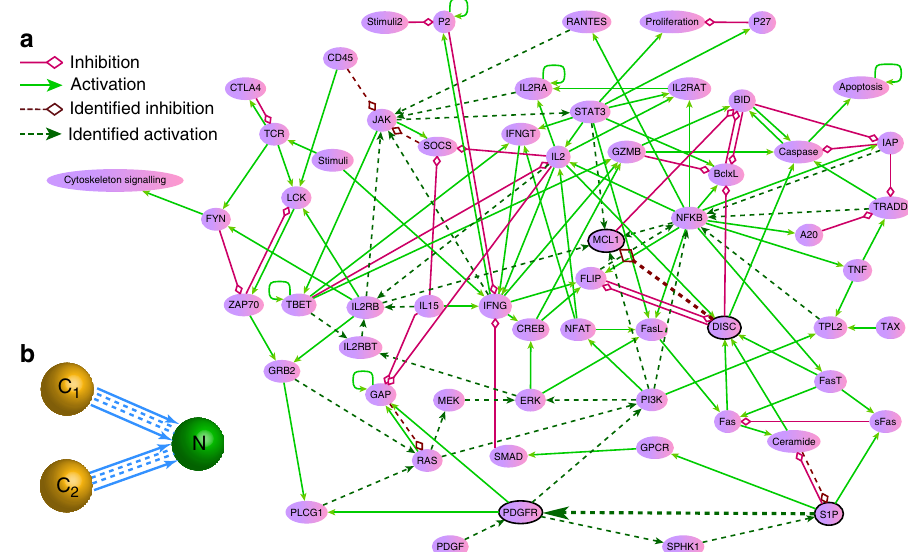
Figure 1 | T-cell survival signalling network and its attractor network. ( a ) Structure of T-cell survival network: each node is labelled with its generic name, and the arrowhead and diamond-head edges represent activation and inhibition regulations, respectively. The inhibitory edges from ‘Apoptosis’ to other nodes are not shown (for clarity). ( b ) Attractor network of the T-cell network, which contains three nodes: two cancerous states denoted as C 1 and C 2 and a normal state denoted as N . The two directed edges in the attractor network are multiple, each containing altogether 48 individual edges corresponding to controlling the 48 edges in the original network, which are indicated by the dark dashed lines, whereas the remaining edges in the original network are signified by the light solid lines. Our detailed computations reveal that parameter perturbation on any one of the 48 edges can drive the system from a cancerous state to the normal state. That is, regardless of whether the initial state is C 1 or C 2 , with a proper modification to one of the 48 parameters, the system can be driven to the normal state N